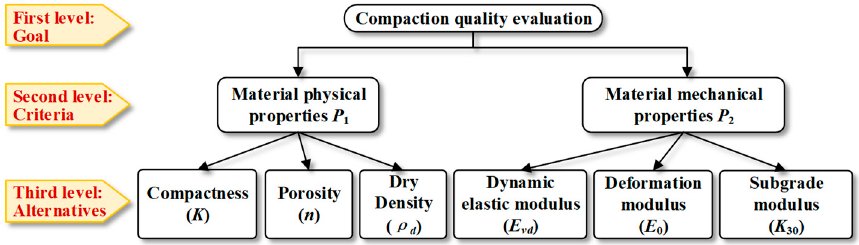
Figure 2. I -AHP system for compaction quality evaluation.